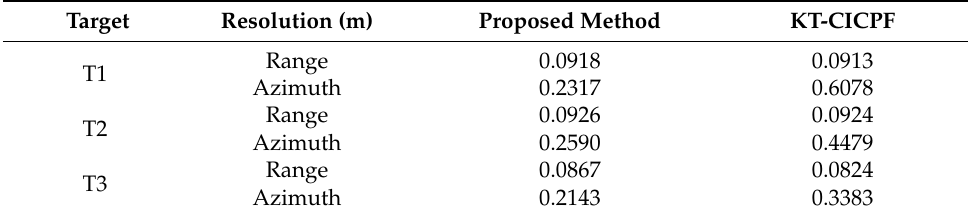
Table 6. The Resolution of measured